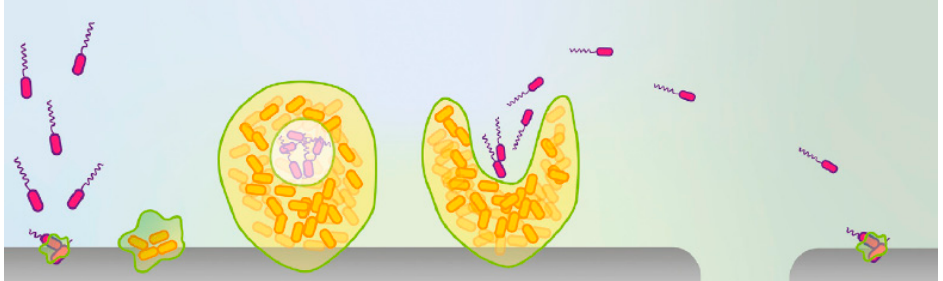
Figure 2. Life cycle of biofilm. Reproduced with permission from Ref [24]. Copyright 2019, Elsevier.